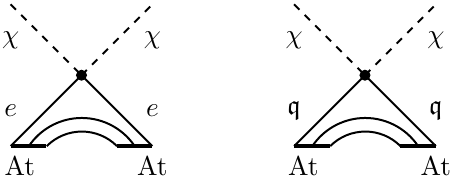
Figure 1 . Contact interaction of DM (cid:31) with the electron or quark components of the nucleus of an atom denoted by